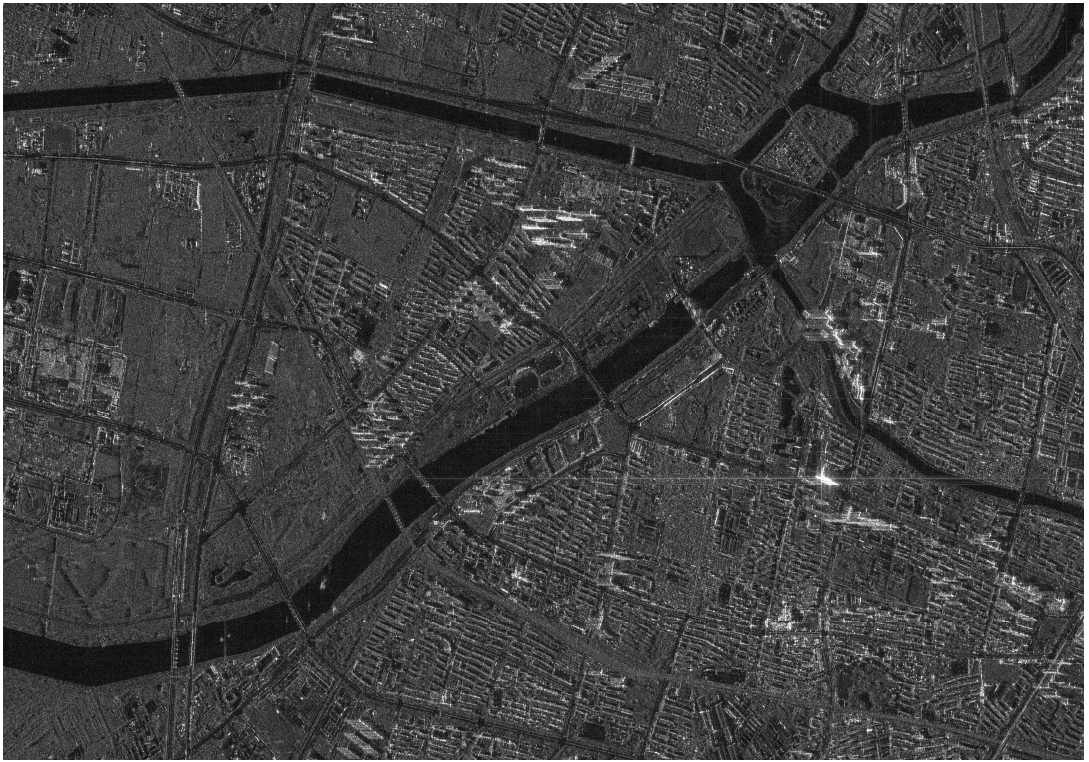
Figure 4. Original synthetic aperture radar (SAR) image.